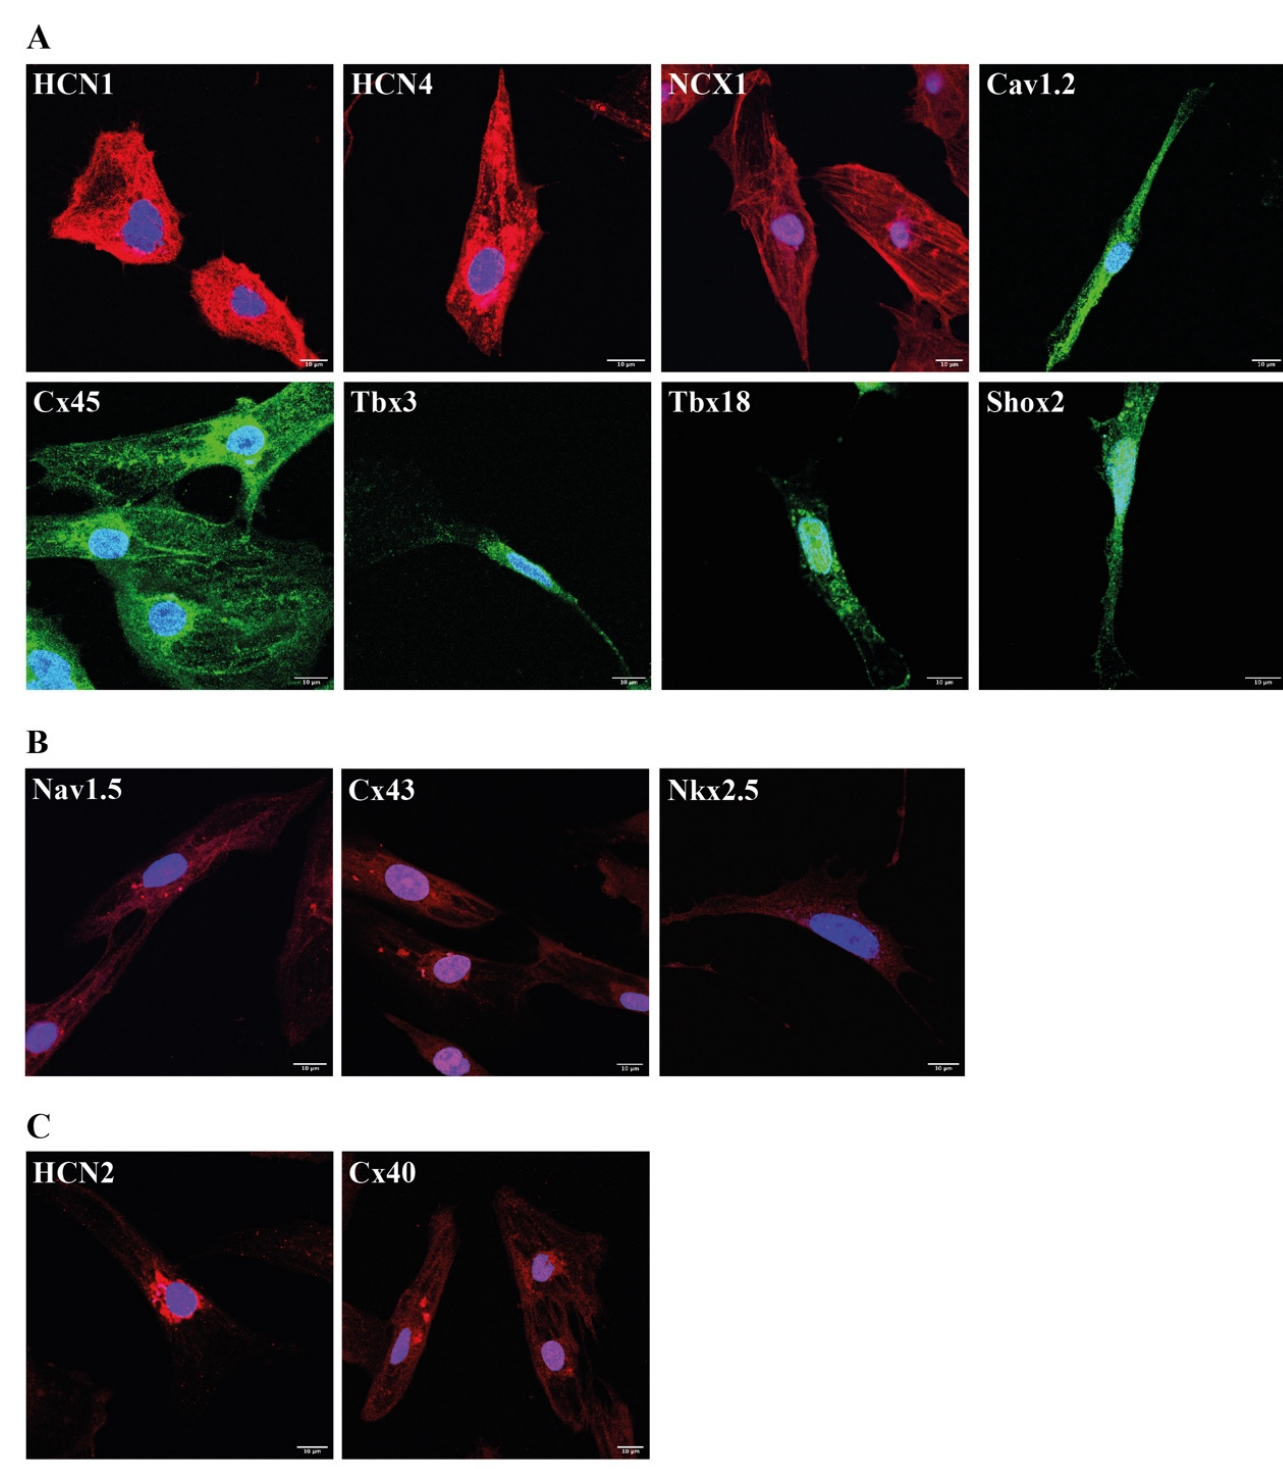
Figure 5. Immunocytochemical analysis of cardiac pacemaker cells differentiated by protocol E. Signals were visualized by confocal microscopy: ( A ): Pacemaker-specific markers. ( B ): Ventricular- specific markers. ( C ): Atrial-specific markers. Nuclei were counterstained with 4 ′ ,6-diamidino-2- phenylindole (DAPI). Scale bars = 10 µm.